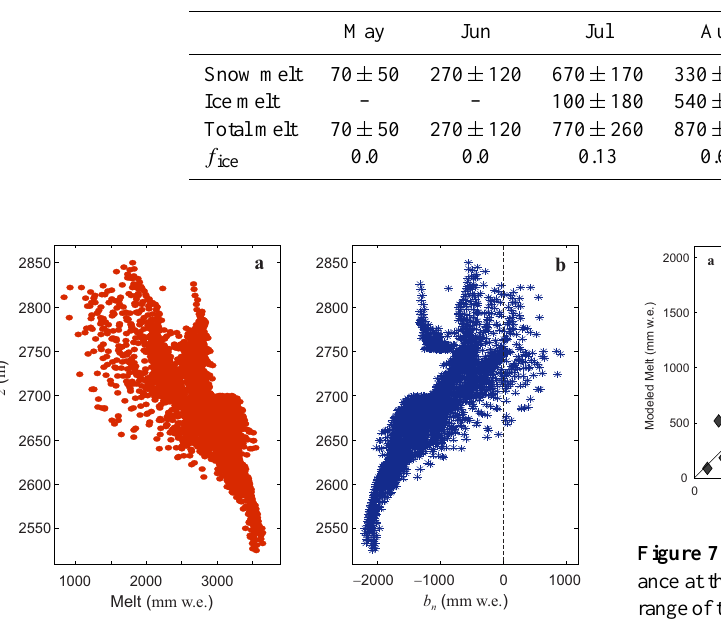
Figure 6. Modelled (a) summer melt and (b) net mass balance vs. elevation (mmw.e.) at Haig Glacier, summer 2012.